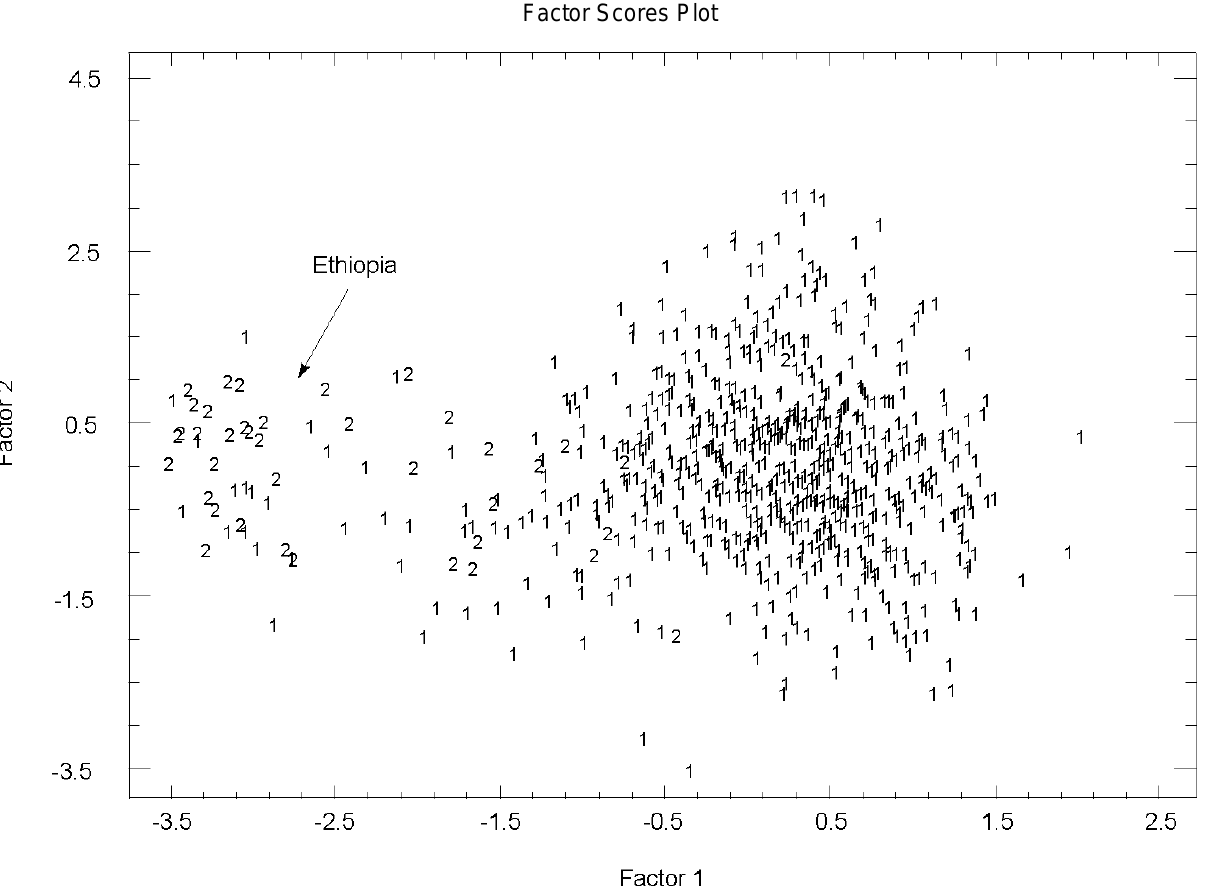
Figure 2 - The graph of the factor scores from factors 1 and 2 shows a large morphocluster to the right of the figure that represents Apis mellifera scutellata bees, and the small cluster to the left represents the honeybees of Ethiopia.